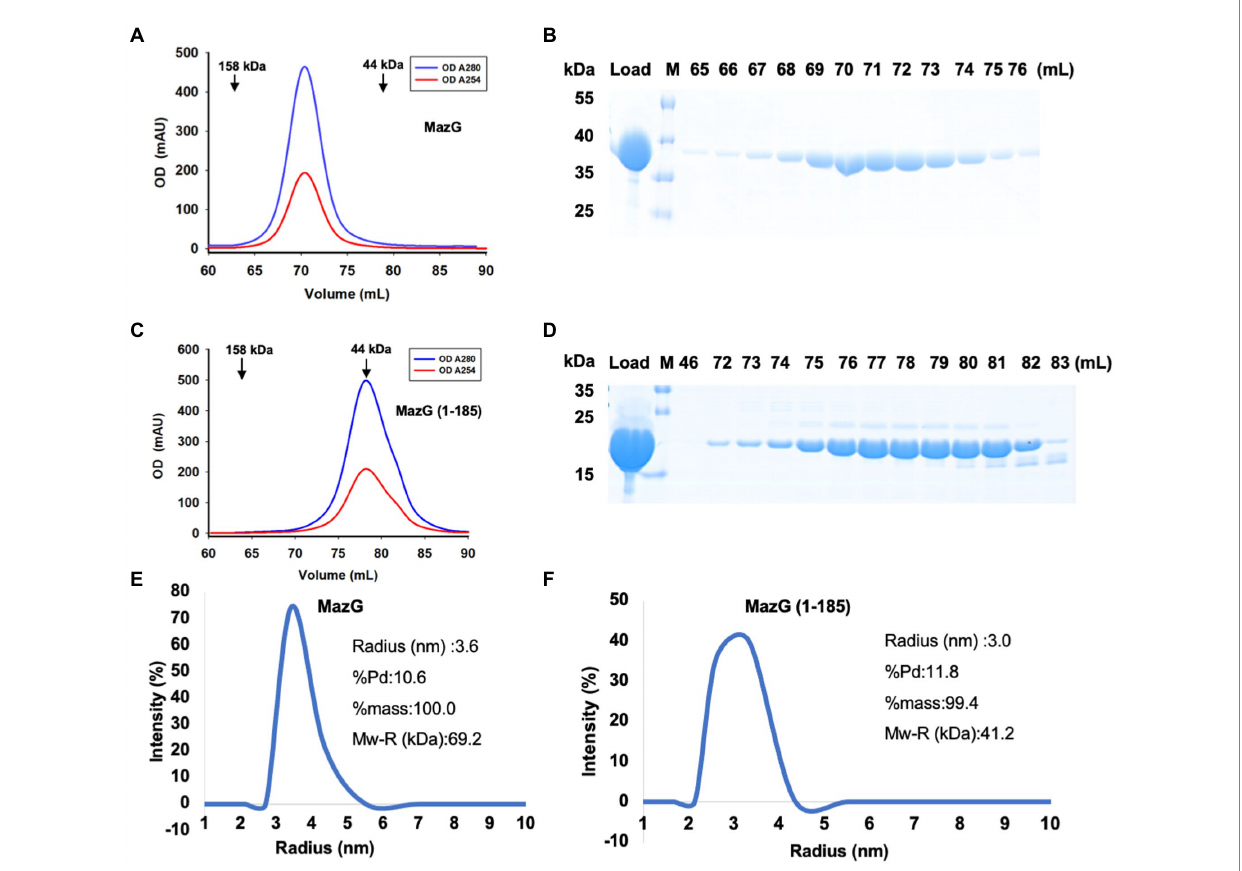
FIGURE 1 Characterization of Mtb-MazG and mutant (1–185) by gel-filtration and DLS methods. (A,C) Gel-filtration profiles of MazG and MazG (1–185) on a Superdex 200 16/600 column. (B,D) SDS-PAGE of the corresponding elution fractions in A,C . M: protein markers. (E,F) The DLS distributions of MazG and MazG